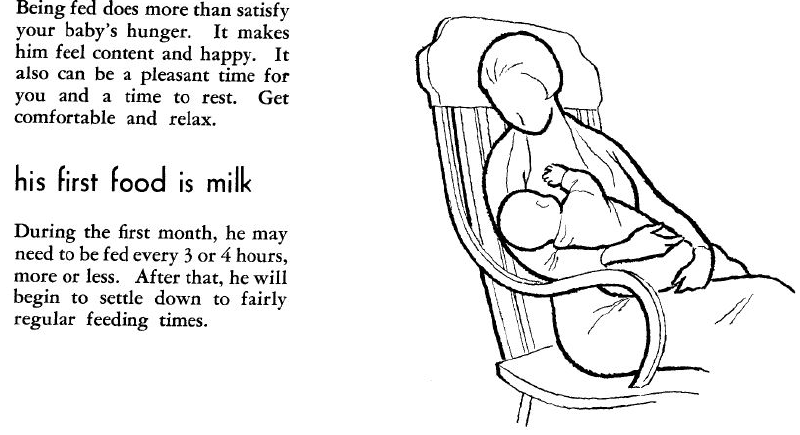
Figure 9. Infant Feeding Provides Nourishment and Affection. The 1989 edition of Infant Care recommended breastfeeding only (no solid food) for baby for the first 4 to 6 months, with nursing continuing until age 1 or beyond. Breastfeeding was described as “the most healthful way of feeding your baby” (U.S. Department of HHS 1989, p. 26). Figure 10 accompanied detailed instructions on positioning the baby for nursing.